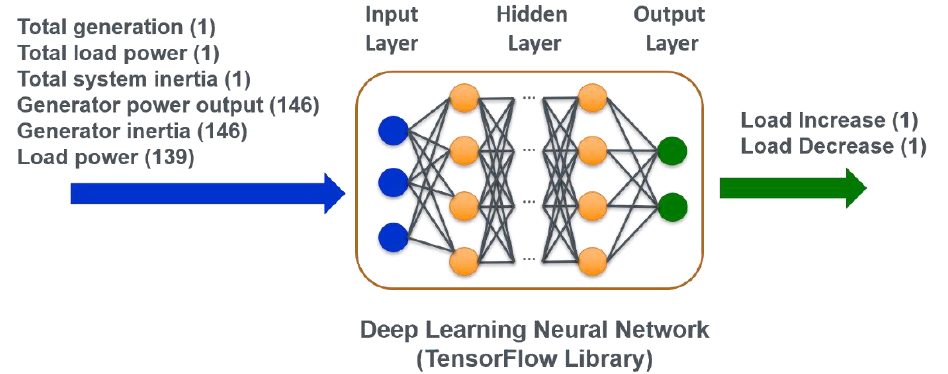
Figure 6. Fundamental components of deep learning neural network.